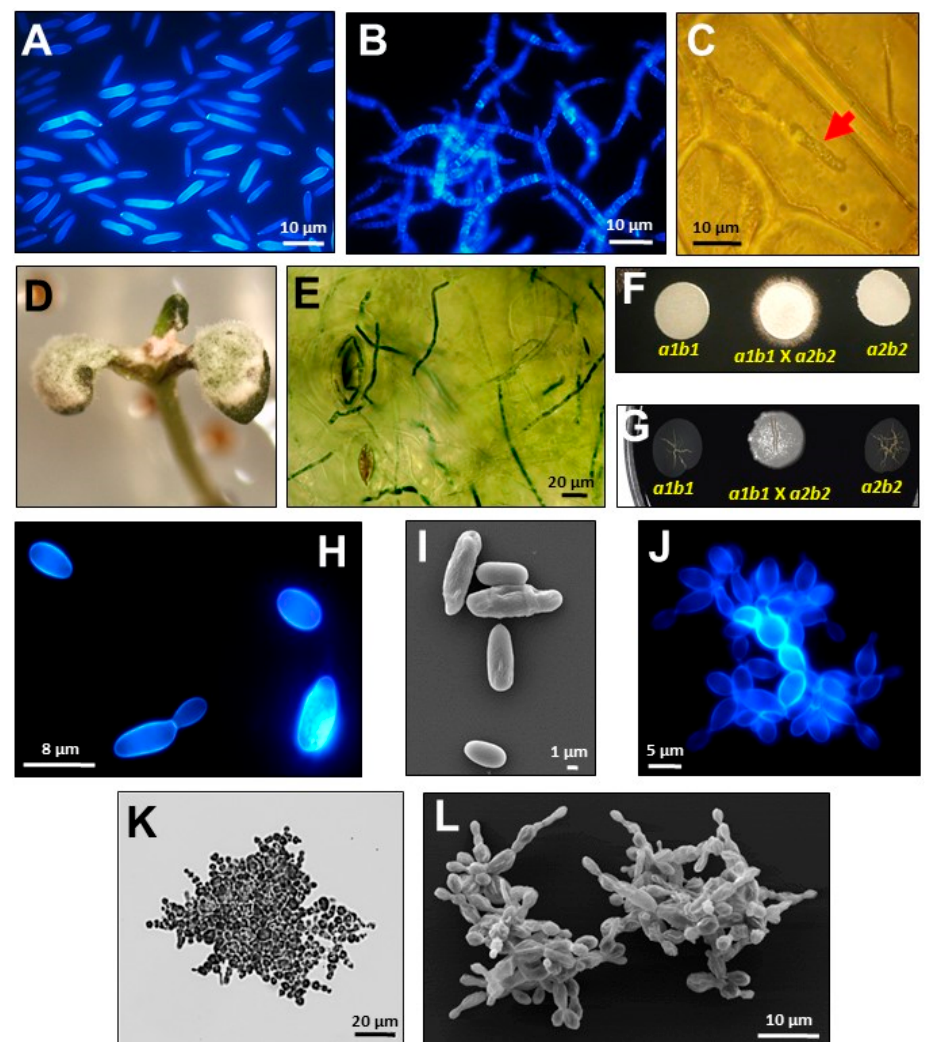
Figure 4. Multicellular shapes developed by Ustilaginomycetes under different growth or development conditions. ( A – F ), Images of U. maydis . ( G – L ) Images of S. reilianum . ( A ) and ( B ) Epifluorescence microphotographs of the fungus showing yeast-like unicellular growth, or multicellular growth as mycelium, in minimal medium pH 7 or pH 3, respectively. ( C ) Multicellular growth of the fungus as mycelium (red arrow) during the colonization of maize plant cells. ( D ) and ( E ) Multicellular growth of the fungus during Arabidopsis infection. ( F) and ( G ) Multicellular growth of fungi as white-fuzzy colonies after mating of sexually compatible sporidia on plates with charcoal containing minimal medium. ( H) and ( I ) Epifluorescence and scanning electron microphotographs of the fungus growing unicellularly like yeasts. ( J – L ) Epifluorescence, bright field, and scanning electron microphotographs of the multicellular clusters of the fungus. In all the epifluorescence microphotographs, the fungi were stained with calcofluor white (Sigma-aldrich, 18909). In ( E) and ( K) , the fungi were stained with cotton blue- lactophenol (Sigma-Aldrich, 61335).